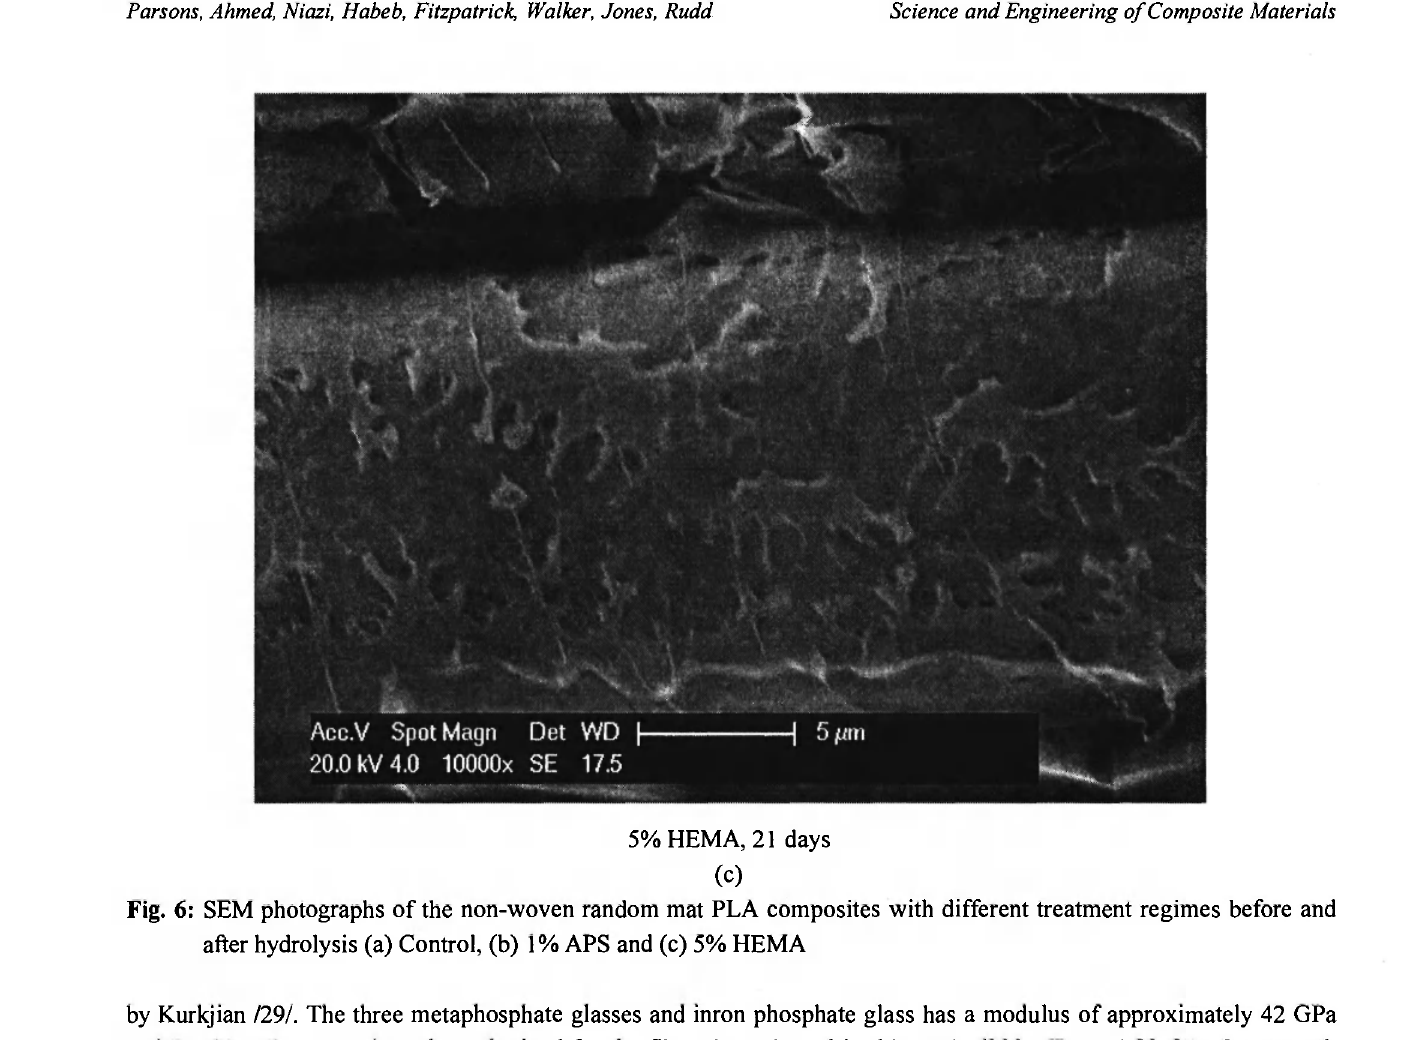
Fig. 6: SEM photographs of the non-woven random mat PLA composites with different treatment regimes before and after hydrolysis (a) Control, (b) 1% APS and (c) 5%